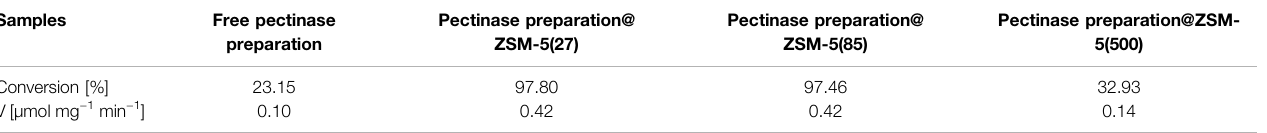
TABLE 2 | Conversion and reaction rates for enzymatic hydrolysis of baicalin.